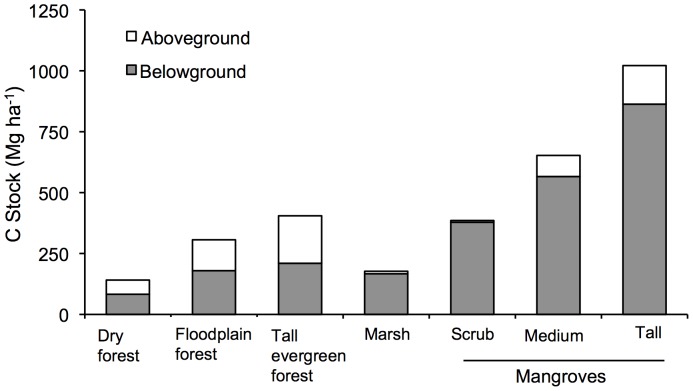
Comparison among C stocks of coastal wetlands of Sian Ka'an Biosphere Reserve with terrestrial forests in Mexico.Terrestrial forests are represented by a dry forest (Chamela, Jalisco [50]), a floodplain forest and an evergreen forests (Los Tuxtlas, Veracruz; [62]). C stocks include aboveground (trees, vines and wood) and belowground (soil and roots) stocks of up to one meter in depth. The tall mangrove forest in the graph was associated to a freshwater spring.